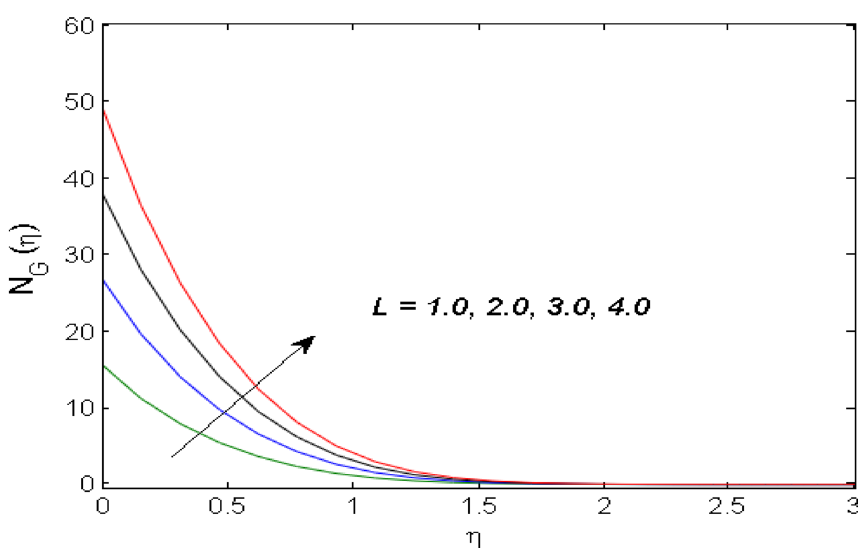
Figure 16. N G (η) versus varied estimates of L